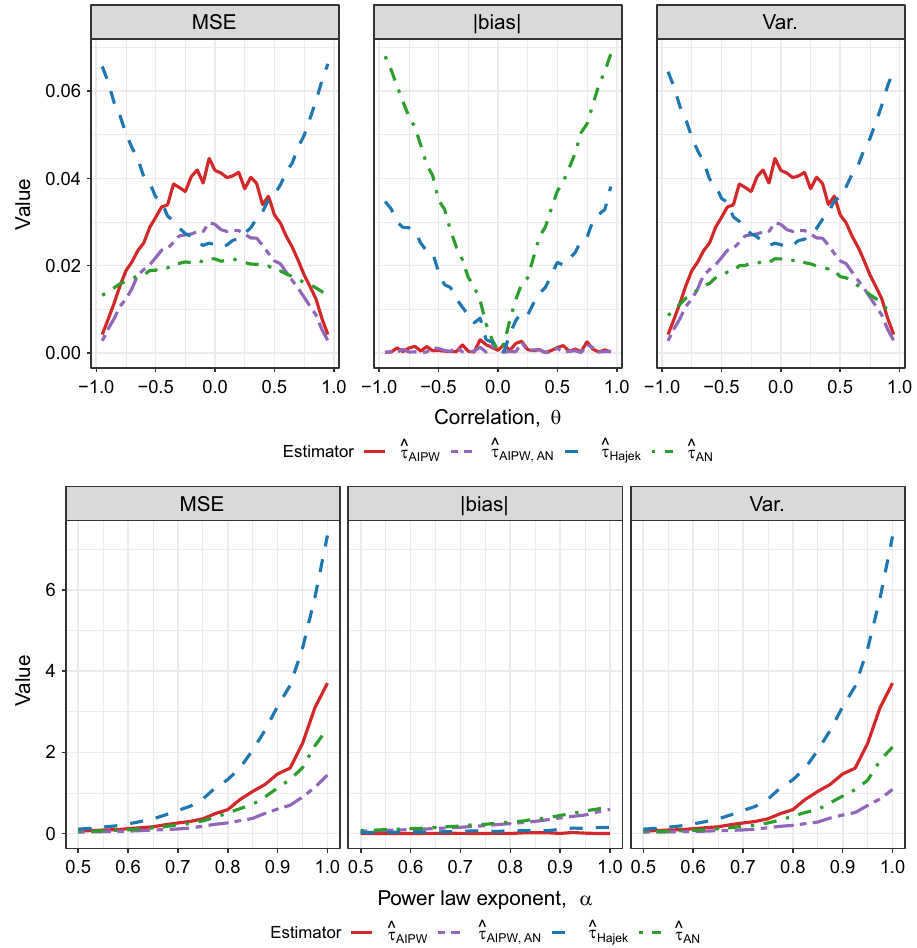
Figure 3: Top: the estimated absolute value of bias, variance, and MSE for estimators applied to data from model ( 18 ) with n 500 = , μ 1 = , and varying θ . Bottom: the same, but with data from model ( 19 ) with n 500 = and varying α . Results are averaged across 10,000 trials. We omit τ ˆ HT due to extremely large variance. Across the board, adaptively normalized estimators e ff ectively trade o ff bias and variance to achieve lower MSE than their traditional